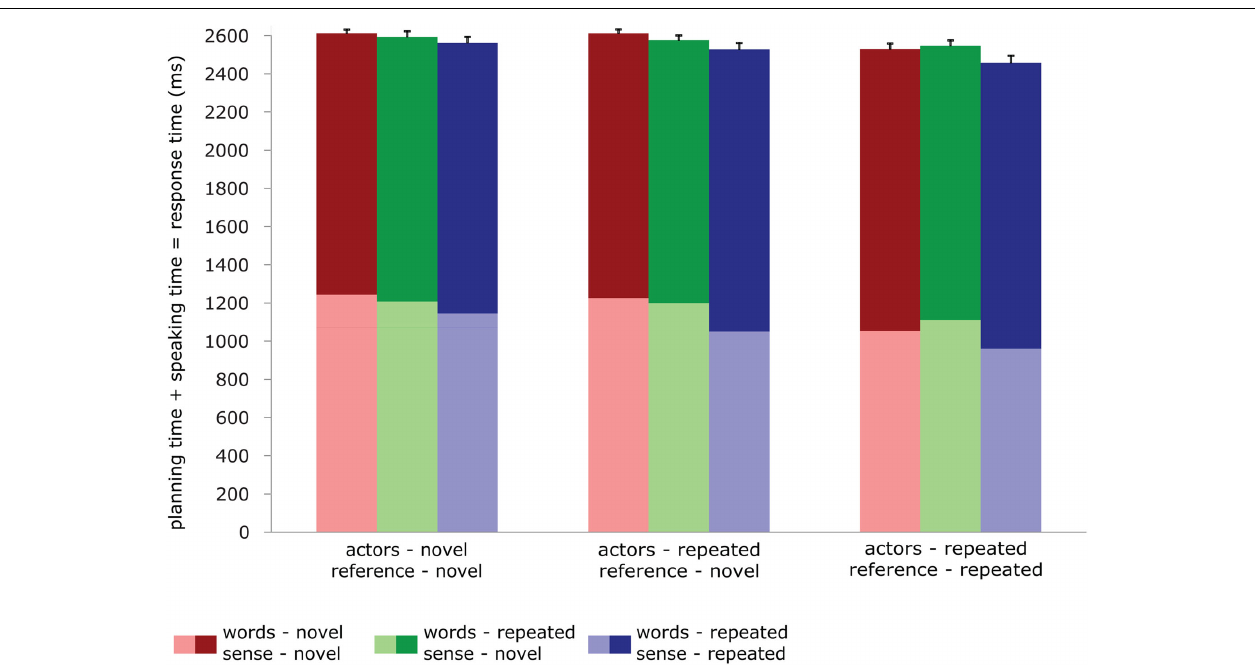
FIGURE 2 | Behavioral data in the speaking experiment: reaction times (light shades), durations (dark shades), and total speaking times (total bar length) for all conditions. Error bars represent SE of the mean of the total speaking times.